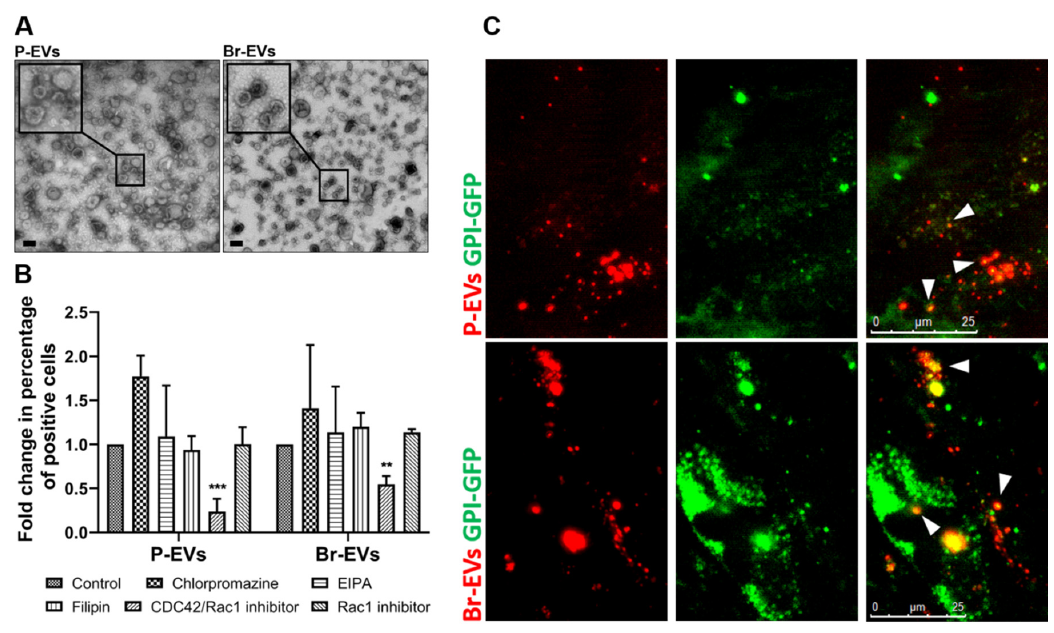
Figure 1. Astrocytes internalize breast cancer-derived extracellular vesicles (EVs) through the Cdc42-dependent clathrin-independent carrier / GPI-AP-enriched compartment (CLIC / GEEC) pathway. ( A ) Electron microscopy images of EVs isolated from parental and brain-seeking MDA-MB-231 breast cancer cells (P-EV and Br-EV, respectively). The square shows magnification of the selected area. ( B ) Flow cytometry quantification of TdTomato-labeled EV (TdTom-EV) uptake by astrocytes treated with chemical inhibitors of endocytosis pathways (mean ± SD; three independent experiments). Statistical analysis was performed using unpaired two-tailed Student’s t -test (** p ≤ 0.01; *** p ≤ 0.001). ( C ) Representative fluorescence microscopy images of the colocalization of TdTom-EVs (red) with GFP-fused glycosylphosphatidylinositol (GPI) (green) in astrocytes from three independent experiments. White arrows show the colocalization of the TdTomato and GFP signals. Scale bar, 25 µm.